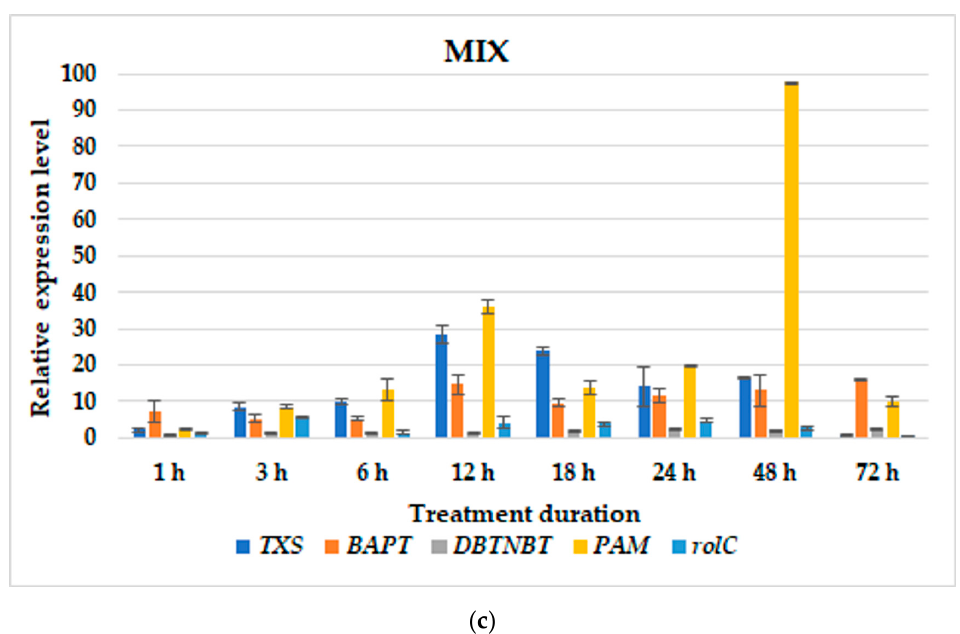
Figure 6. The effect of BABA1 treatment followed by ETOH ( a ), MeJA ( b ) or MIX ( c ) elicitation on relative gene expression profiles in hairy root cultures. Data represent mean values ± SD from three independent experiments.